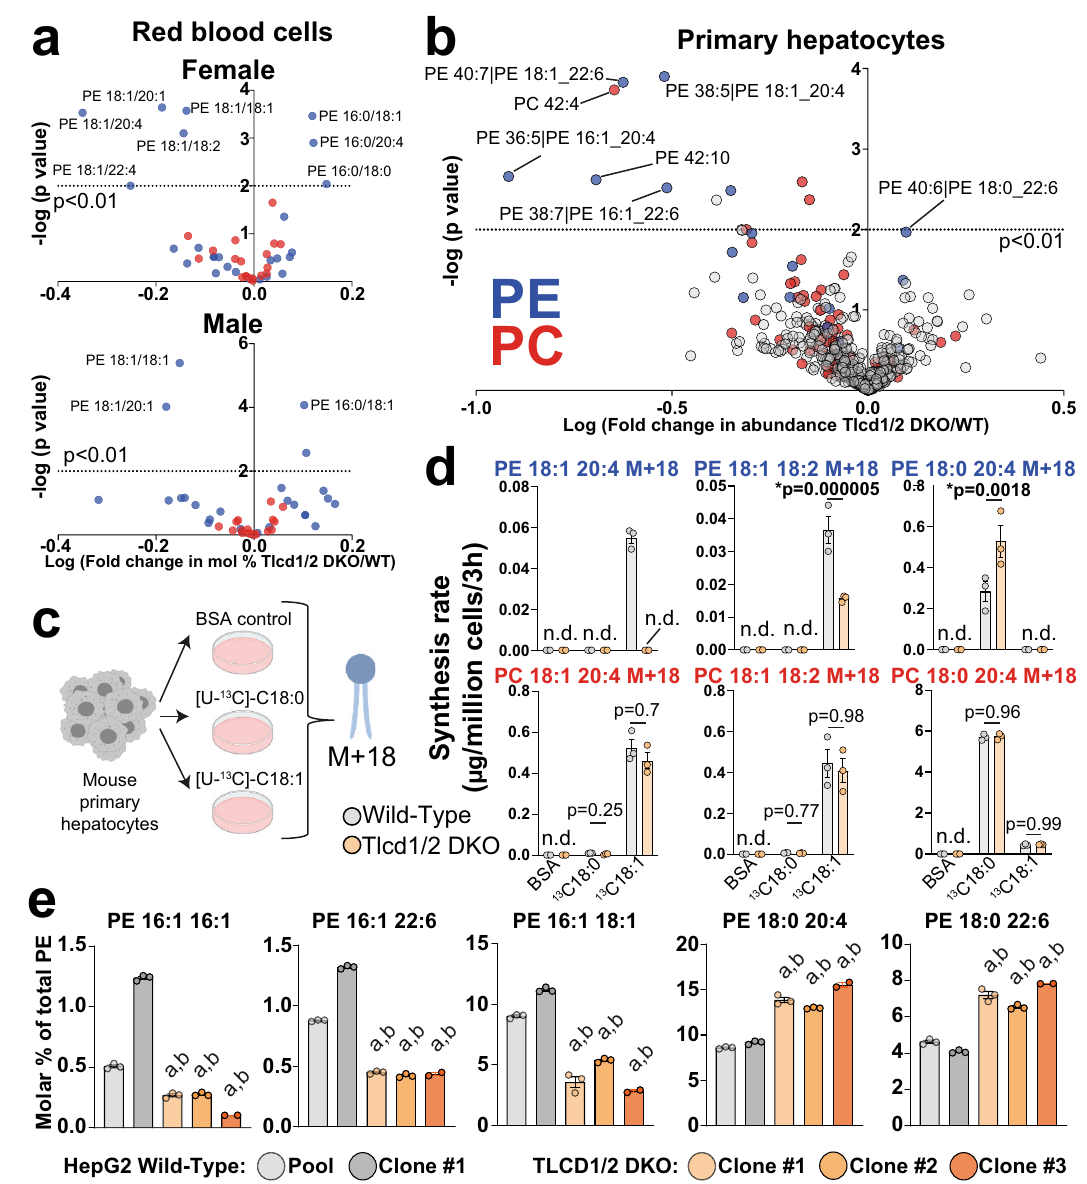
Fig.2|TLCD1/2promoteMUFAincorporationintoPEspeciesinacell-intrinsic manner. a Volcano plots of selected PC (19 species, red) and PE (26 species, blue) species measured in red blood cells isolated from 8-month-old male ( n =12 WT, 11 Tlcd1/2 DKO) and female (6 WT, 9 Tlcd1/2 DKO) mice. b Volcano plot of lipid species measured with high con fi dence (492 species in total, PC indicated in red and PE in blue) in primary hepatocytes isolated from Wild-type and Tlcd1/2 DKO chow-fed, 3-month-old female mice ( n =3 mice/genotype) after 2 days of culture. c Outline of PE pulse-labeling experiment. d The levels of indicated PE and PC speciescontainingstablelabel(mass+18Da)inprimaryhepatocytesisolatedfrom wild-type and Tlcd1/2 DKO chow-fed, 3-month-old female mice ( n =3 mice/geno- type),treatedwith 100 µ M [U- 13 C] − 18:0 or − 18:1 for 3h. e The levelsof indicated PE